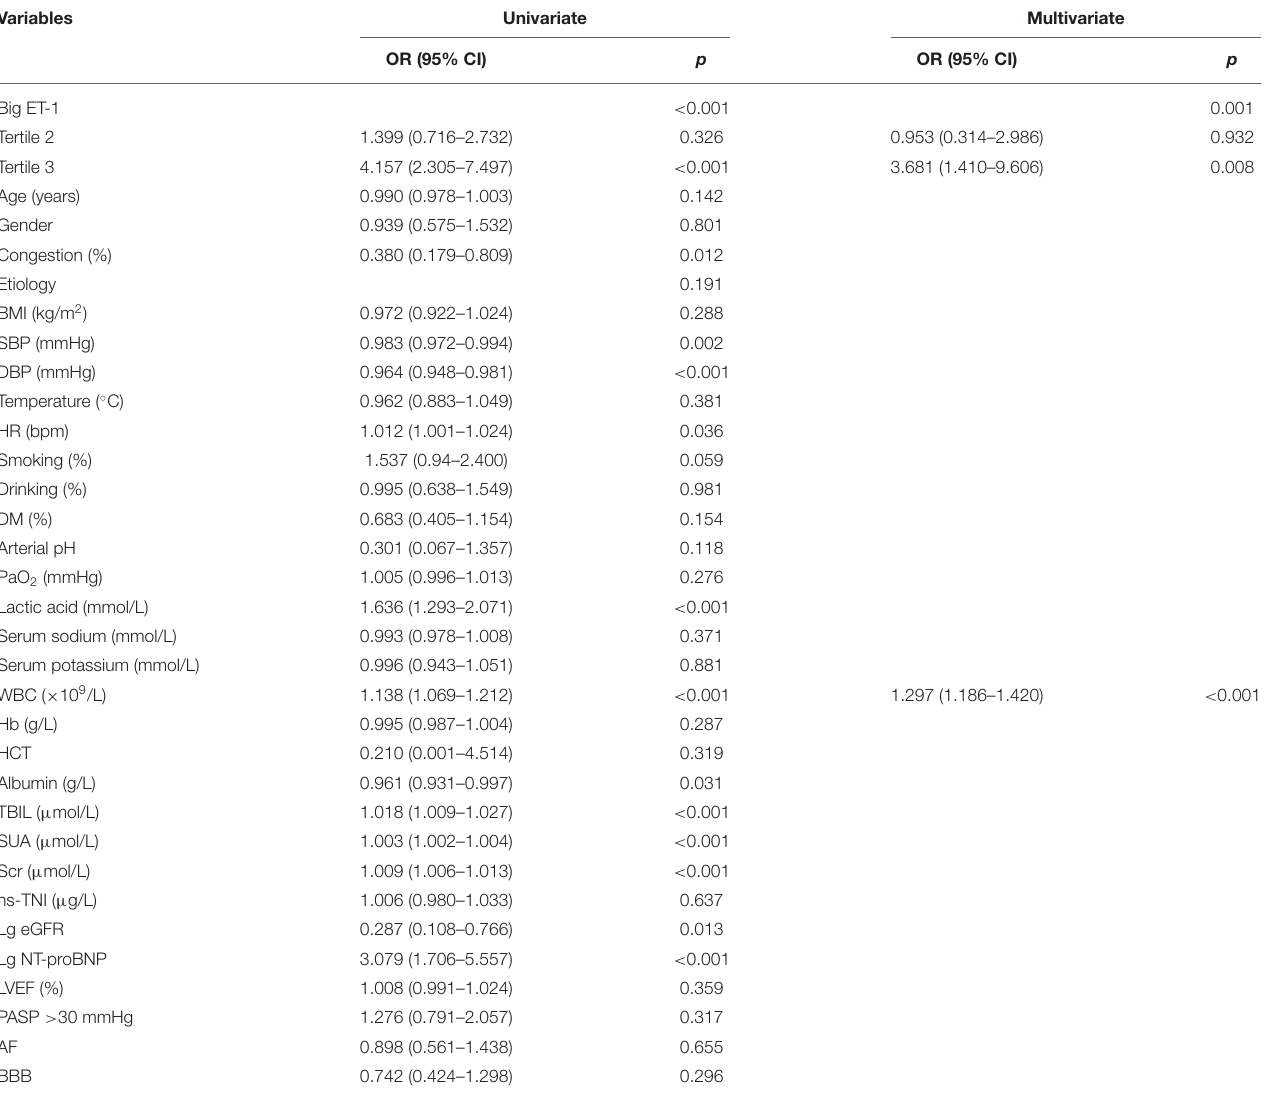
TABLE 3 | Predictor of primary endpoint in uni- and multivariate logistic